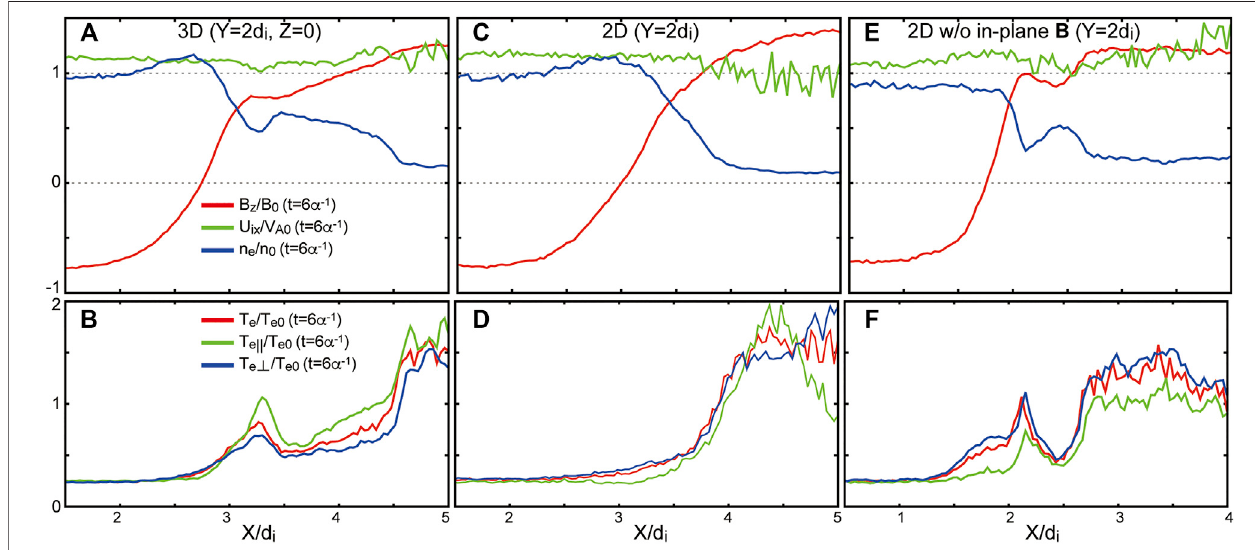
FIGURE 3 | Quantities of the same three runs at t (cid:1) 6 α − 1 along the dashed lines marked in Figure 2 (the same lines in panels of the second row from the top in Figure1 ).Thetoppanelsshowtheout-of-planemagnetic fi eld(B